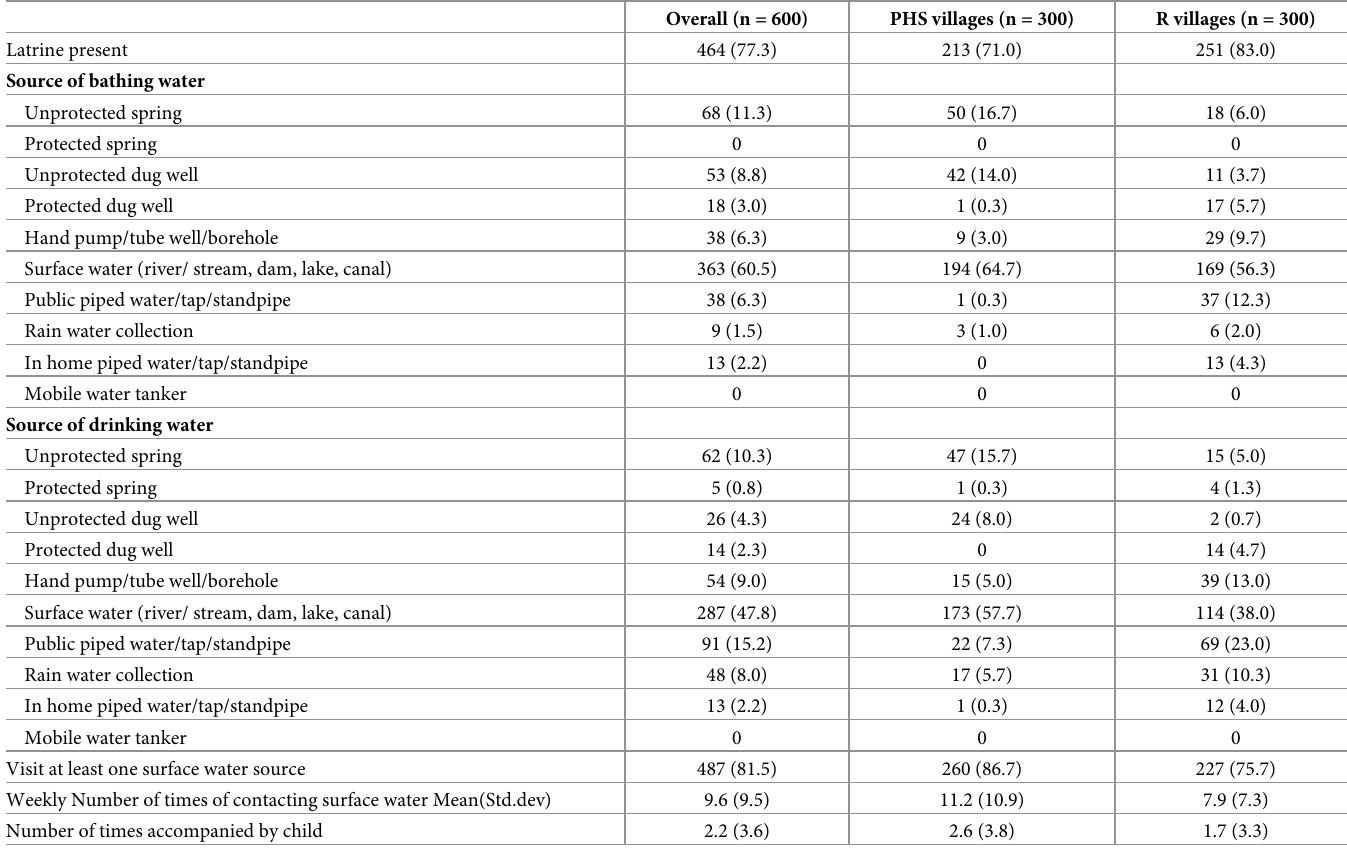
Table 4. Descriptive statistics on water, sanitation and hygiene in study villages based on village data from household heads.